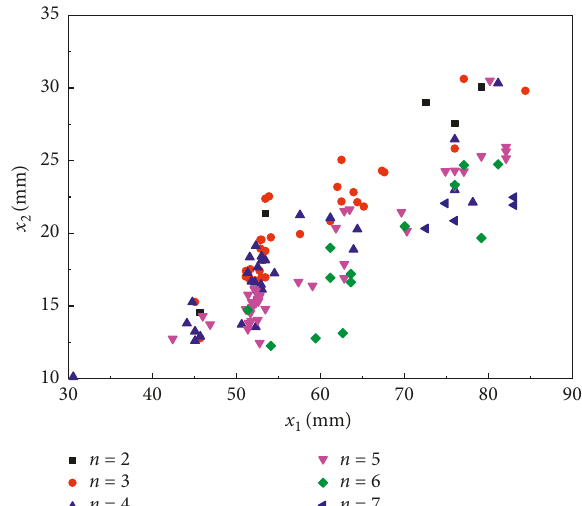
Figure 8: Size change before and after impact breakage.